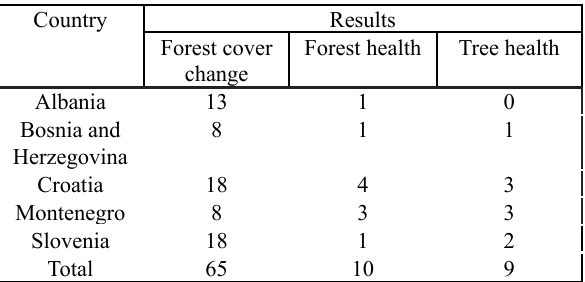
Table 2 . The number of publications found at Scopus searching for forest cover change, forest health and tree health